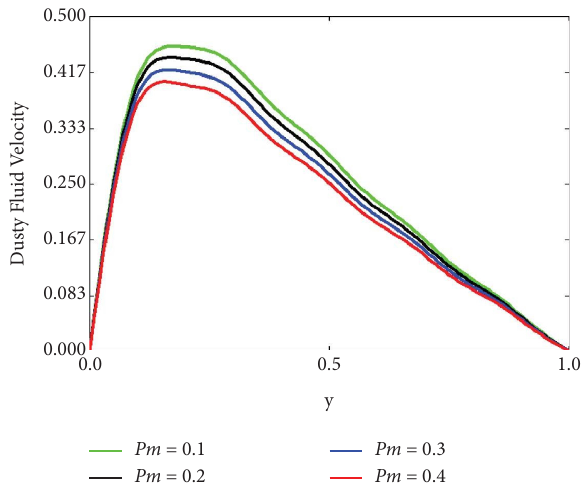
Figure 13: Te impact of diferent values of Re on ψ